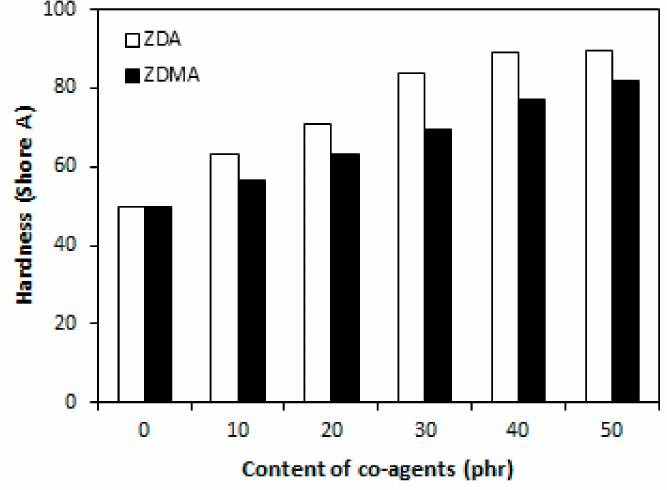
Figure 4. Influence of co-agents content on hardness of